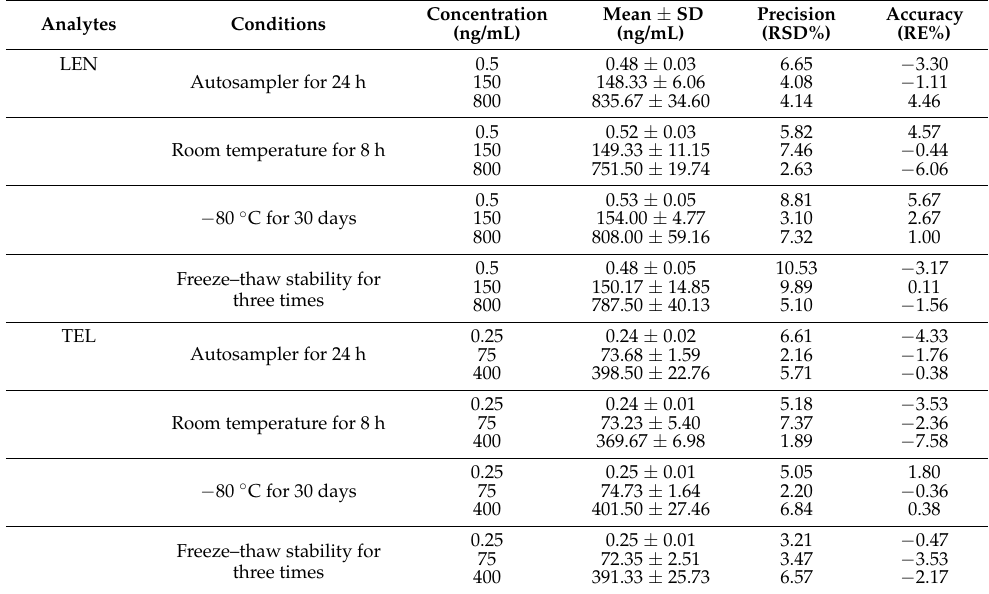
Table 3. Stability of LEN and TEL in rat plasma under various storage conditions ( n =